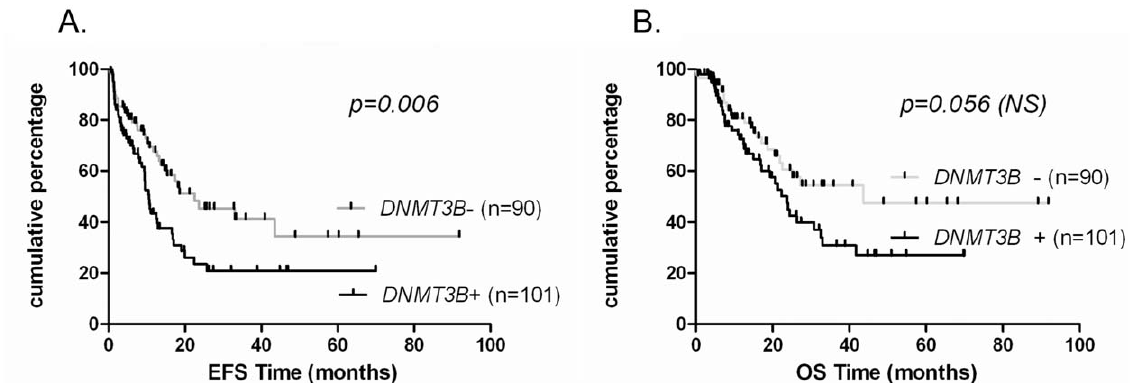
Figure 6. High DNMT3B expression associates with poor event free survival. Kaplan-Meier analysis of two groups with expression levels above or below the cut-off as described in method section for DNMT3B EFS (A) and OS (B) were assessed in 191 patients.